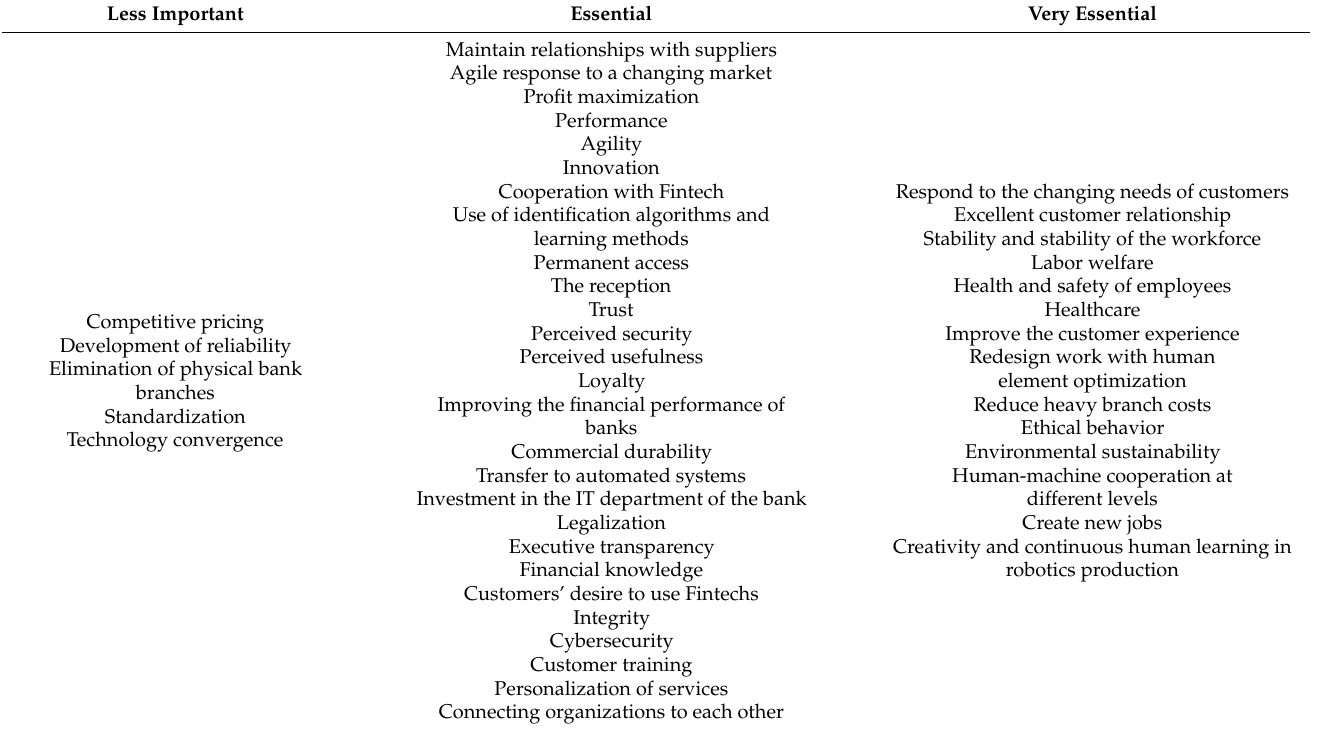
Table 5. Classification of indicators from the perspective of experts (Ref: